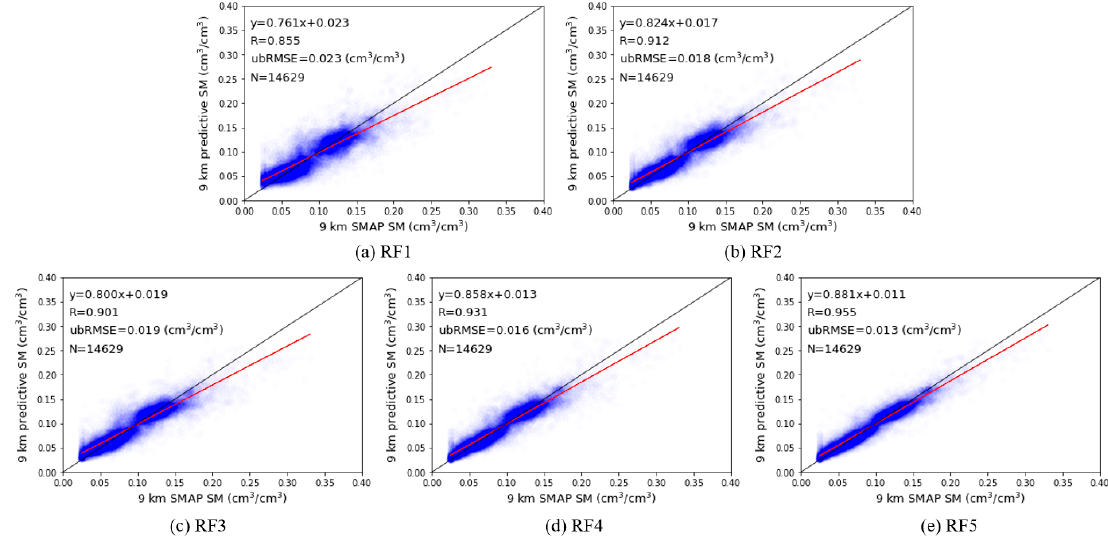
Figure 4. Comparison between the 9 km predictive SM data based on the RF1–RF5 models and 9 km SMAP L3_SM_P_E SM data. N is the number of samples.